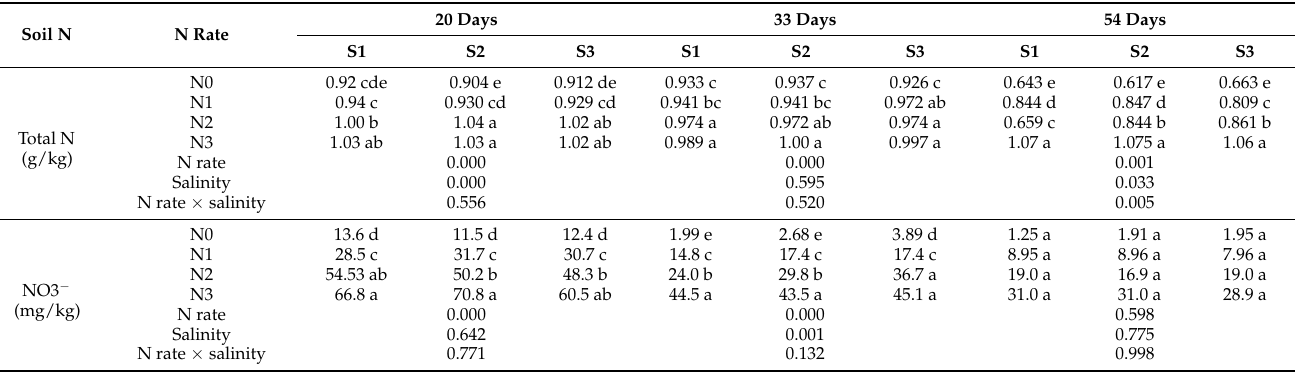
Table 4. Effects of nitrogen application rates on soil total N and soil NO 3- in different growth stages of winter wheat in various salinity level soils.